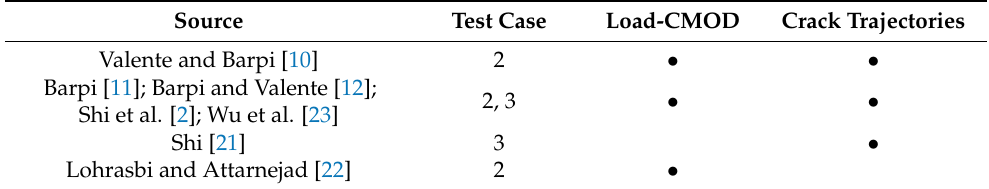
Table 2. Benchmark information availability considering finite elements with discrete crack models. Source Test Case Load-CMOD Crack Trajectories Valente and Barpi [10]